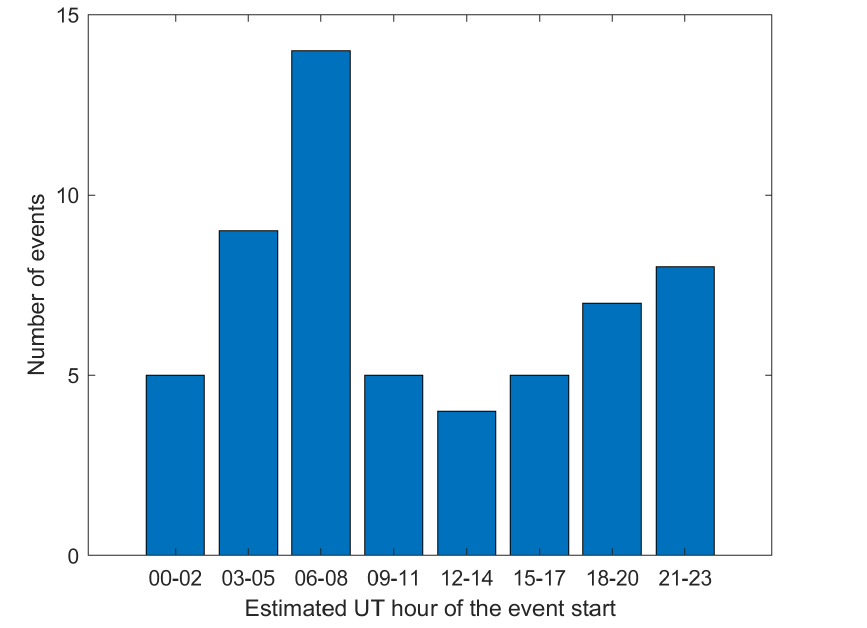
Figure 9. Histogram of the estimated UT hour of the geomagnetic storm beginning over three-h